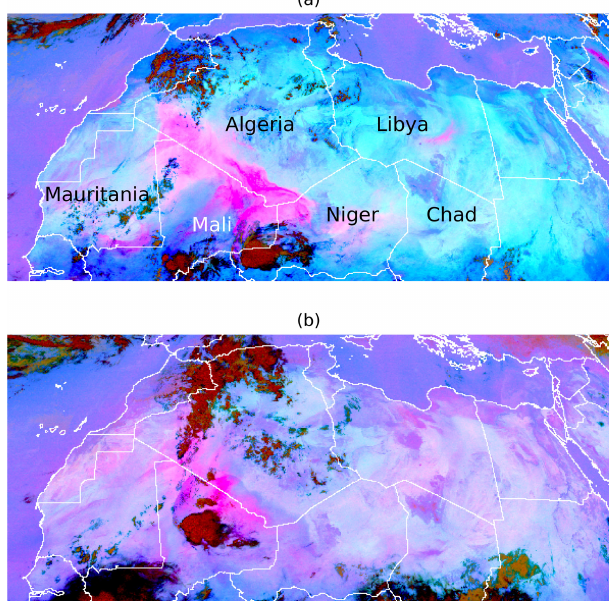
Figure 1. SEVIRI Desert Dust RGB images from (a) 12:00UTC on 17 June 2012, and (b) 00:00UTC on 18 June 2012.